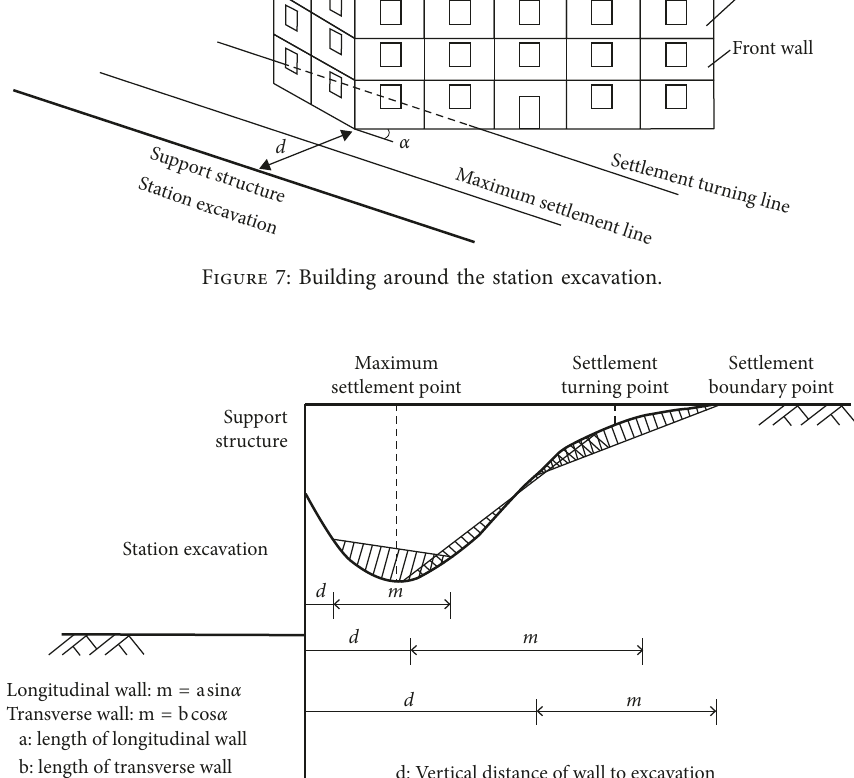
Figure 8: Bending deformation of a wall.